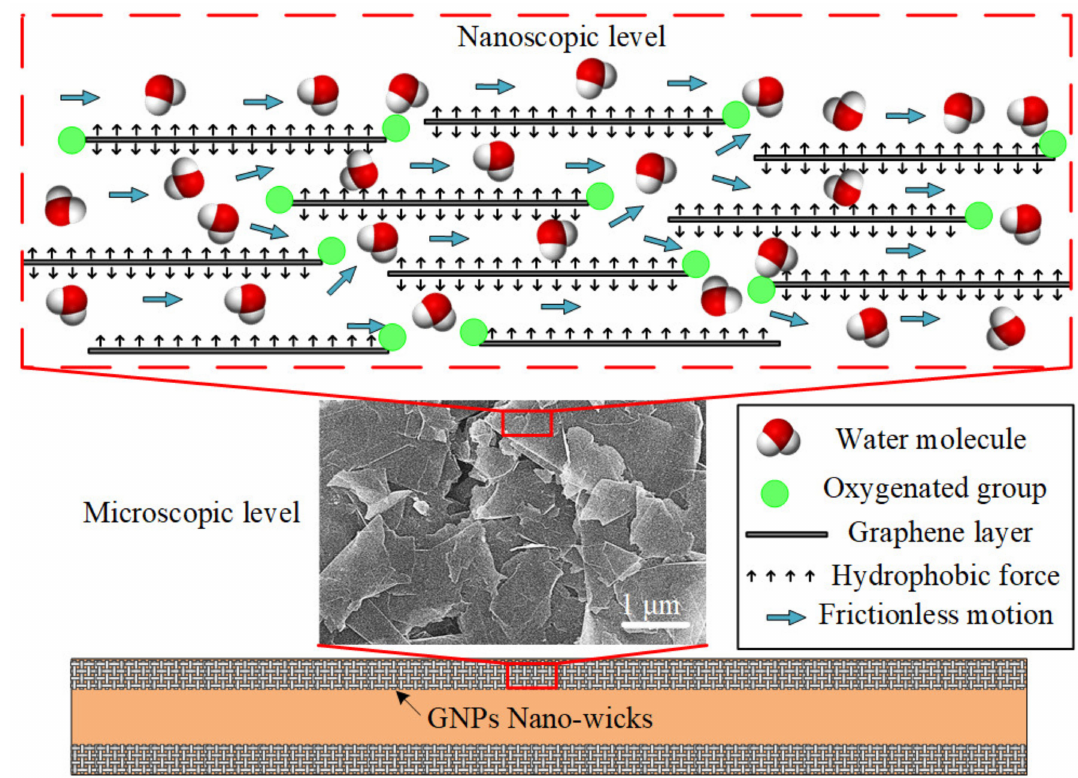
Figure 7. Schematic depicting the nano-wicks formed on the inner-wall surface of a microchannel. At the microscopic level, the platelet-by-platelet structure of GNPs is observed. At the nanoscopic level, each nanoplatelet consists of several graphene layers of which the gaps between them form a network of